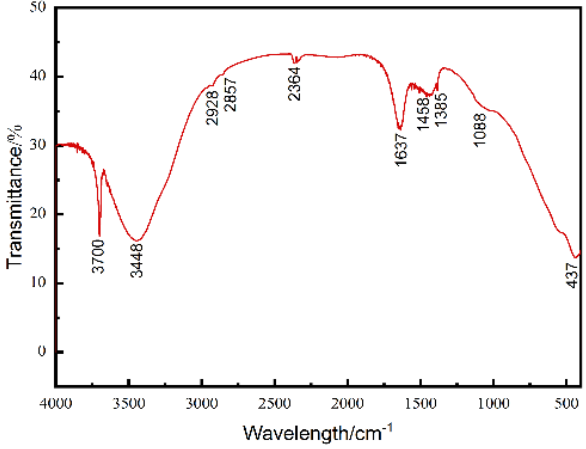
Figure 9. FT-IR spectra of as-produced Mg(OH) 2 .